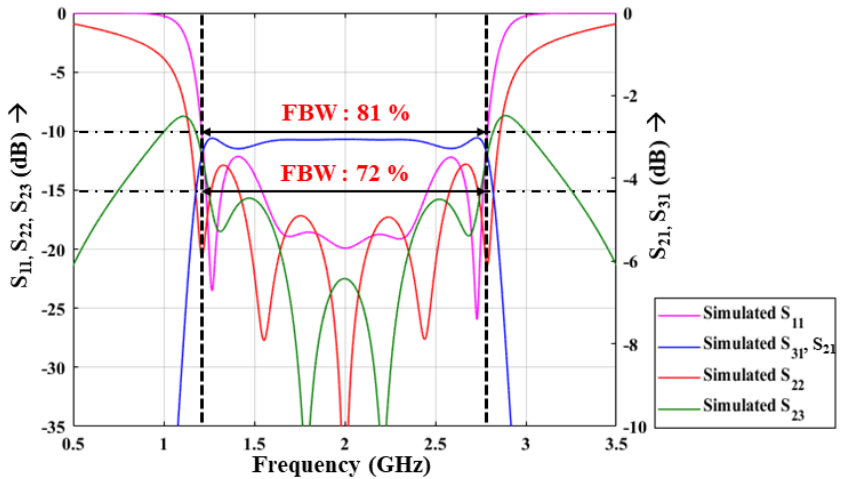
Figure 20. Simulated S − parameters (dB) for θ c = 60 ◦